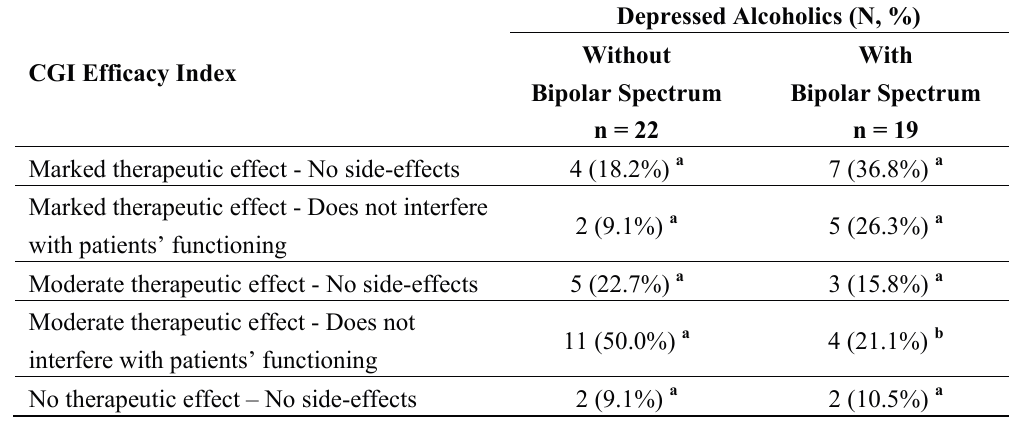
Depressed Alcoholics (N, %) Without With Bipolar Spectrum Bipolar Spectrum n = 22 n = 19 2 (9.1%) a 5 (26.3%) a